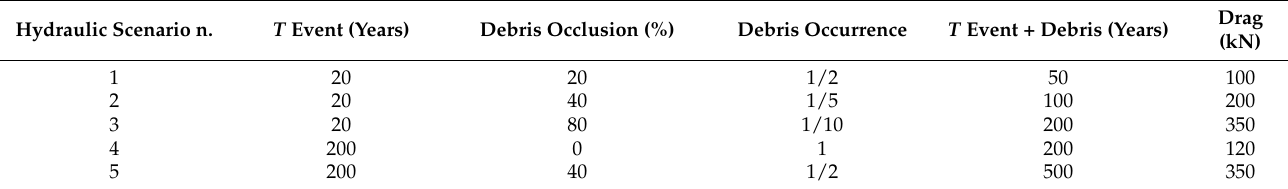
Table 1. Hydraulic actions computed for different hydraulic